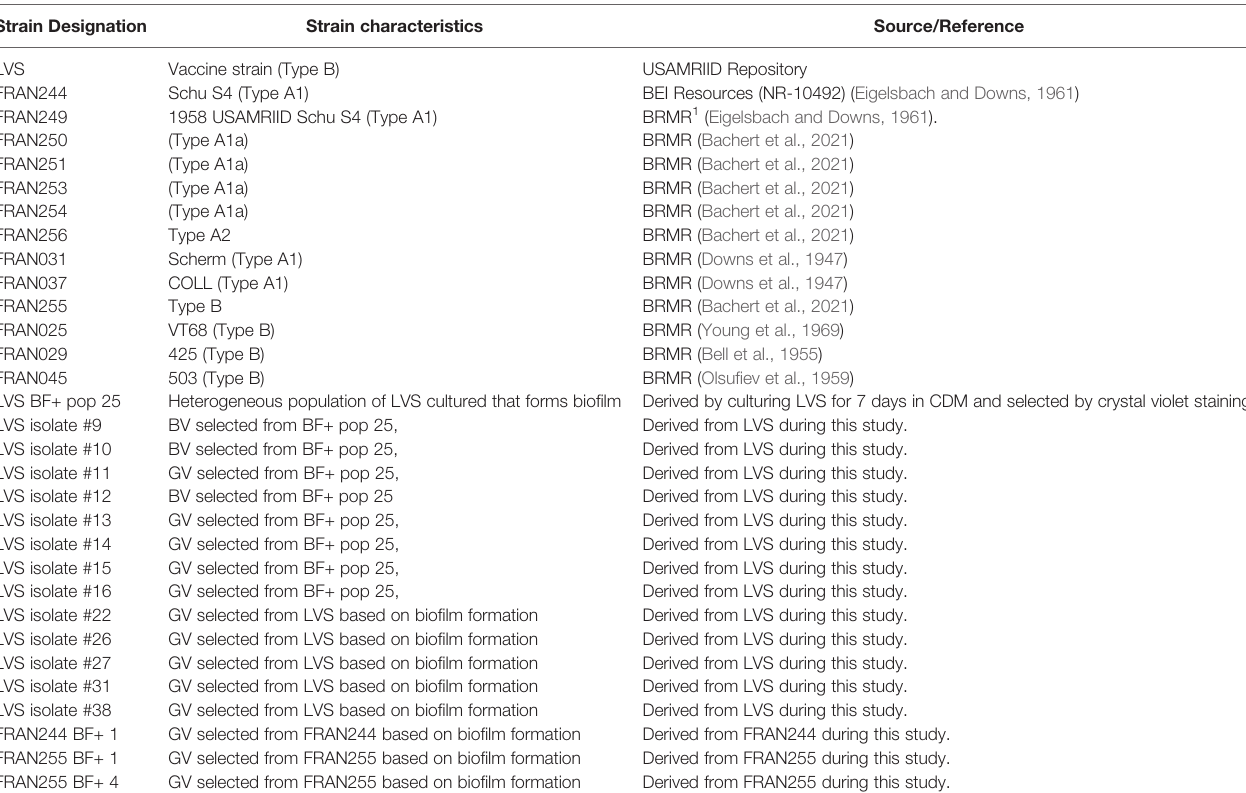
TABLE 1 | Bacterial strains used in this